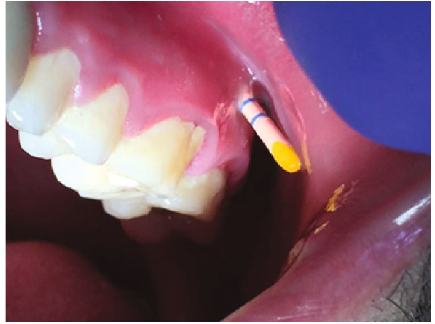
Figure 5: Gutta-percha inserted through sinus.